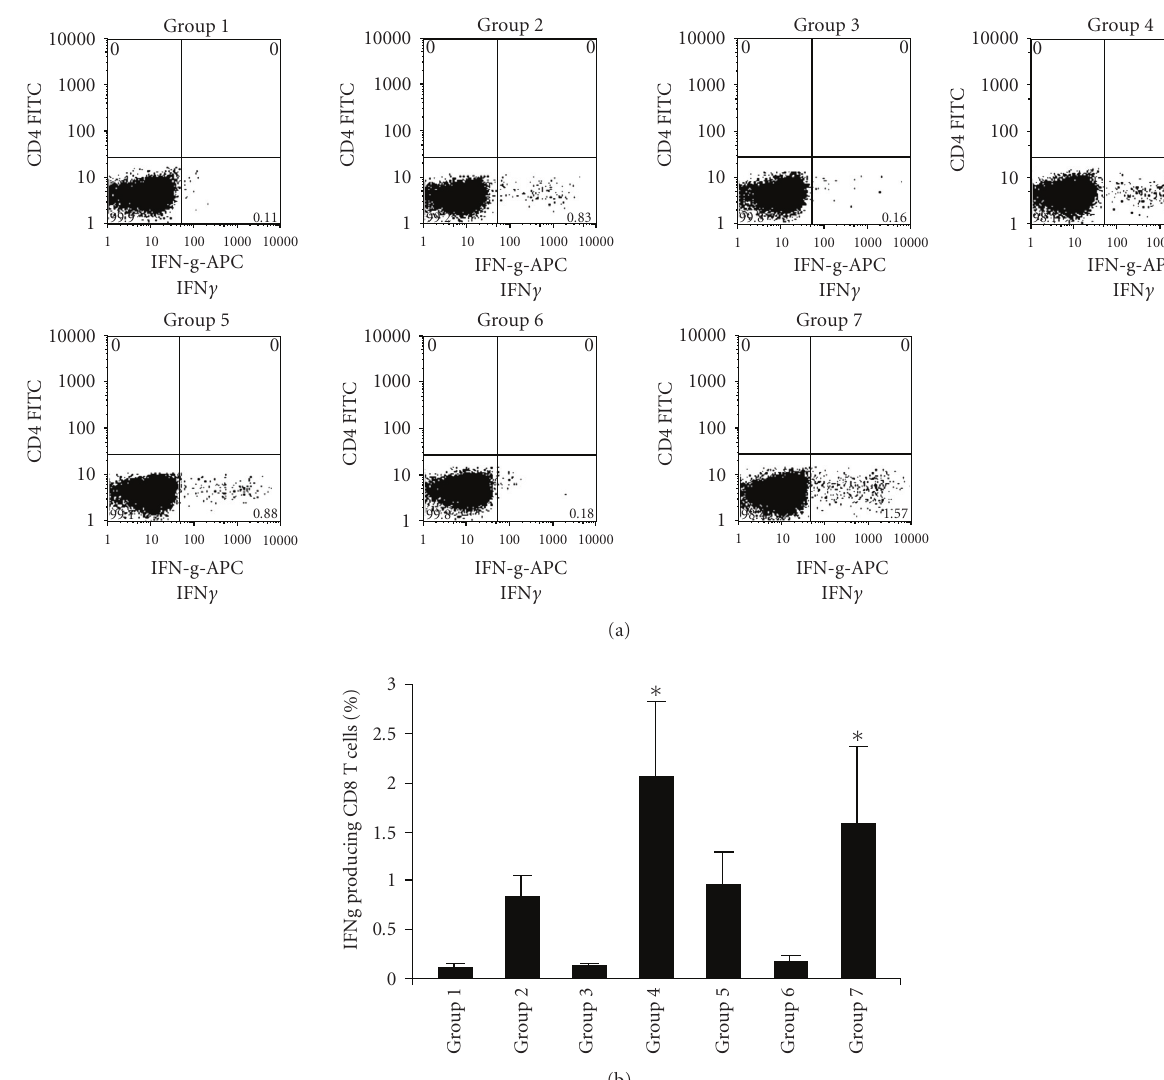
Figure 3: Enhanced CD8 T cell responses by immunization with a mixture of HIV Env-DNA and SHIV 89.6 VLPs but not by simultaneous injection at separate sites. Groups of mice (6 per group) were immunized by intramuscular injection at weeks 0 and 4 with di ff erent vaccine preparations as shown in Figure 2. Two weeks after the second immunization, mouse splenocytes were prepared and stimulated by the peptide IGPGRAFYAR corresponding to the dominant CD8 epitope in the HIV Env for Balb/c mice. The percentages of IFN γ -producing CD8 T cells were analyzed by intracellular-cytokine staining and flow cytometry. (a) Representative results of FACS analysis for IFN γ - producing CD8 T cells from each immunization group stimulated with the peptide IGPGRAFYAR. Numbers in lower-right boxes represent percentages of IFN γ staining positive CD8 T cells. Background levels of IFN γ -producing CD8 T cells similar to Group 1 were obtained for all samples stimulated with an irrelevant peptide AMQMLKETI (data not shown). (b) Percentages of IFN γ staining positive CD8 T cells for each immunization group after stimulation with the peptide IGPGRAFYAR. Error bars represent standard deviations for each group. ∗ indicates the groups with significantly higher levels of CD8 T cell responses than Group 2 that received the HIV Env-DNA vaccine only ( P < .